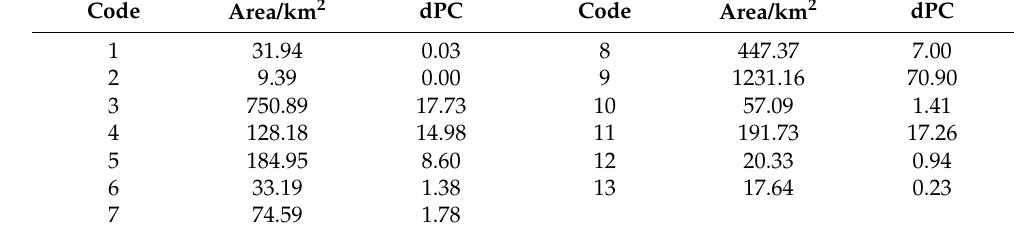
Table 3. Evaluation table of the landscape importance of the ecological source.